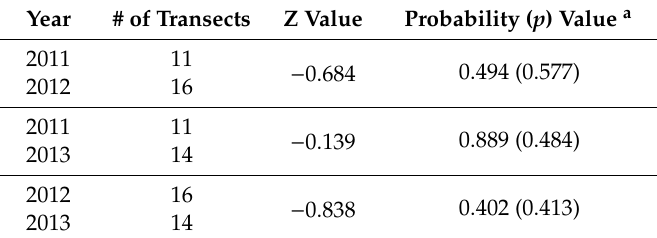
Table 3. Results of the Wilcoxon rank-sum test [38] used for testing the null hypothesis of carbon loss from mining, indicating that there is no di ff erence in carbon loss from mining across the years 2011, 2012, and